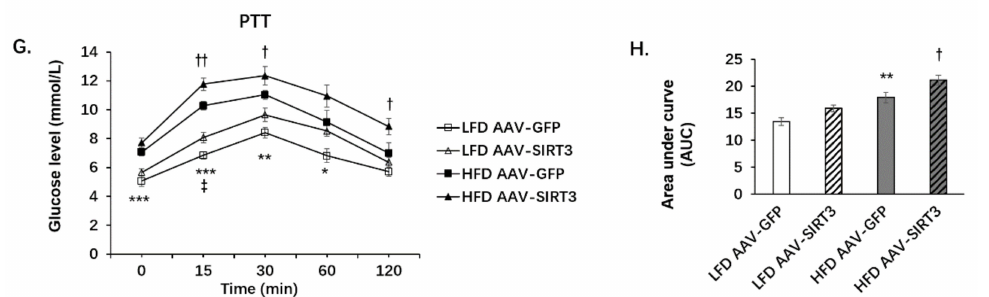
Figure 5. Liver-specific SIRT3 overexpression increases gluconeogenesis. C57BL/6N male mice of 5–6 weeks of age were injected with AAV-GFP or AAV-SIRT3 via a tail vein and fed with LFD or HFD for 12 weeks, respectively. At the 13th week, PTT was performed. At the 14th week of feeding, mice were euthanized, and liver tissues were collected. ( A ) Protein level of SIRT3 in liver. ( B ) RNA level of SIRT3 in liver. ( C ) Protein level of SIRT3 in adipose tissue. ( D ) Quantification of SIRT3 protein level in adipose tissue. ( E ) Protein level of SIRT3 in muscle. ( F ) Quantification of SIRT3 protein level in muscle. The data are mean ± s.e. (error bars). n = 6 mice per group. **, p < 0.01, AAV-GFP vs. AAV-SIRT3. ( G ) PTT. Mice were fasted overnight and intraperitoneally injected with pyruvate (2 g/kg). Blood glucose levels were measured before injection and 15, 30, 60, and 120 min after injection. ( H ) Area under curve of PTT. The data are mean ± s.e. (error bars). n = 6–9 mice per group. §, p < 0.05, LFD AAV-SIRT3 vs. HFD AAV-SIRT3; *, p < 0.05, **, p < 0.01, ***, p <